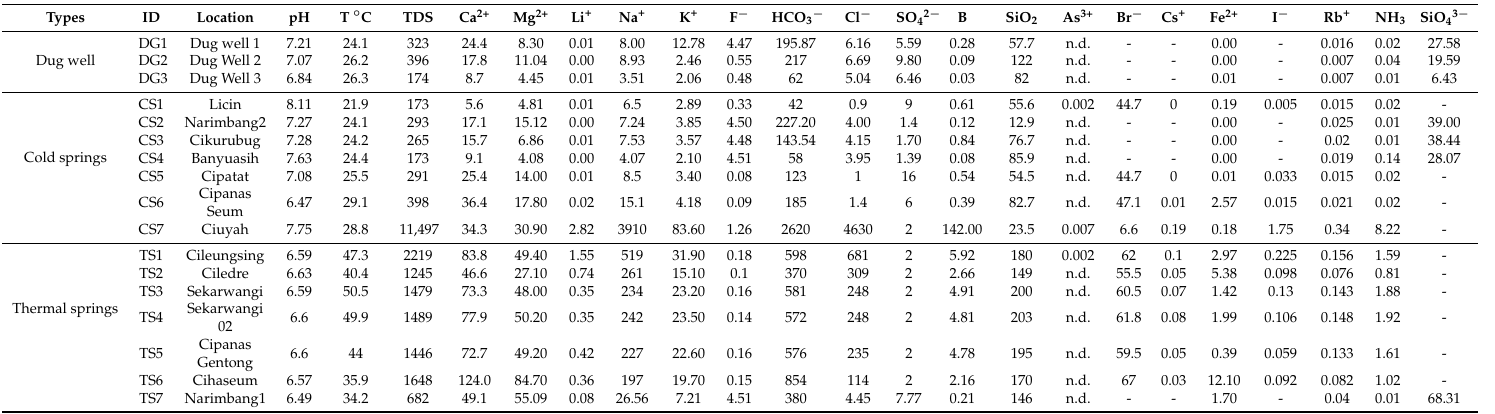
Table 1. Physico-chemical composition of water samples in springs and dug wells in the Tampomas area. DG represents dug well; CS represents cold spring; and TS represents thermal spring. TDS and concentration of ions are in mg/L